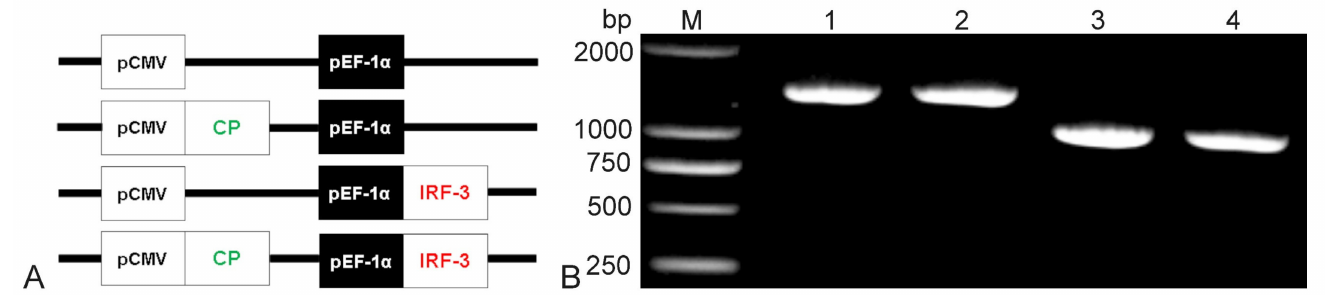
Figure 2. Construction of the bicistronic recombinant plasmid schematic structures of P, C-P, P-I, and C-P-I ( A ). The CP gene was inserted downstream of CMV promoter; the IRF3 gene was inserted following the EF-1 α promoter. Results of agarose gel electrophoresis of recombinant plasmids PCR ( B ). Lane M: DL2000 DNA marker; Lane 1: P-I recombinant plasmid; Lane 2–3: C-P-I recombinant plasmid; Lane 4: C-P recombinant plasmid. P: pBudCE4.1 group; P-I: pBudCE4.1-IRF3 group; C-P: CP-pBudCE4.1 group; C-P-I: CP-pBudCE4.1-IRF3